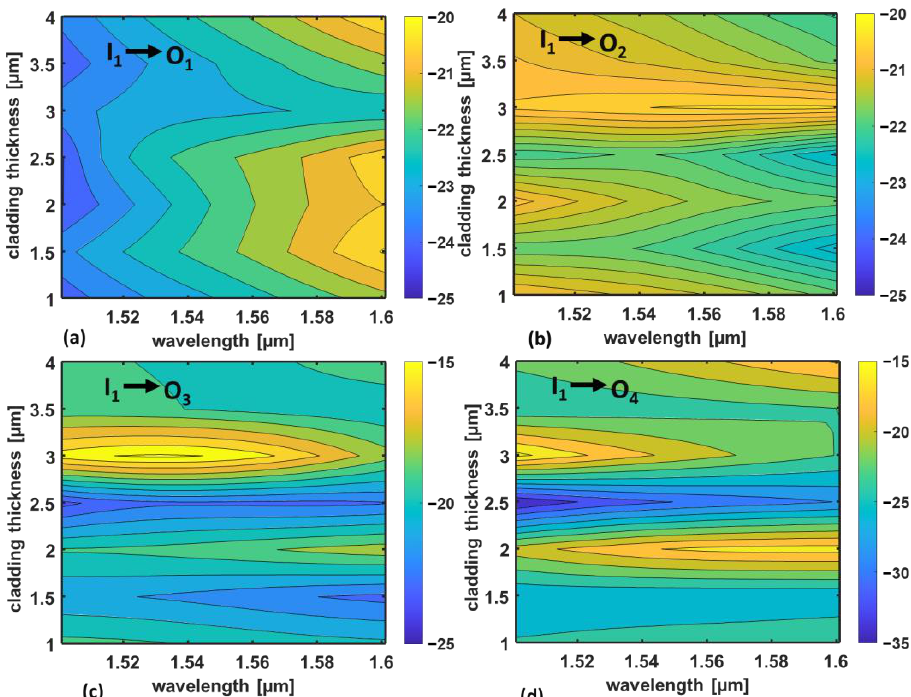
Figure 5. Crosstalk in dB, calculated as a function of the wavelength and of the cladding thickness, at the receiving OPAs, i.e., O 1 , O 2 , O 3 , and O 4 , when the transmitting OPA I 1 is excited: ( a ) XT 21 , ( b ) XT 12 , ( c ) XT 23 , and ( d ) XT 24 . The simulated device exploits reconfigurable OPAs made of N = seven taper antennas with a taper length L T = 2 μm. The link distance is d link = 70 μm.